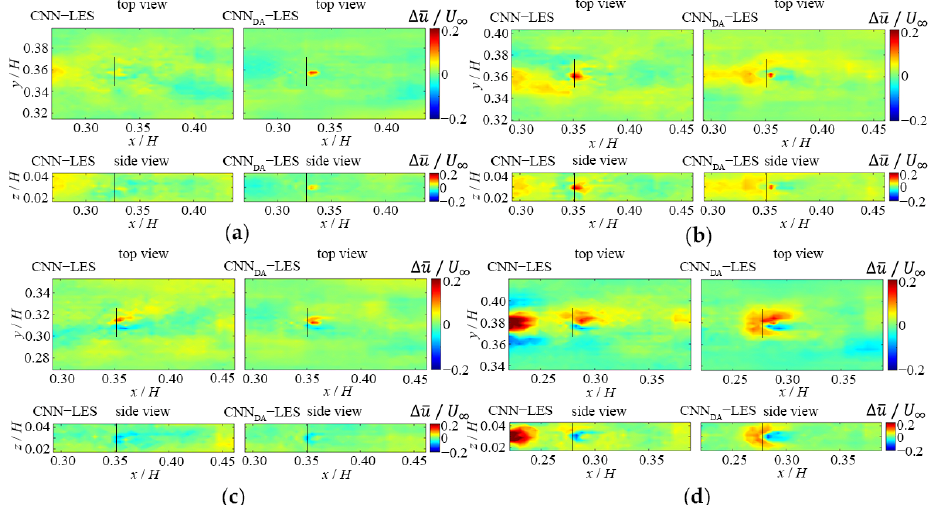
Figure 15. Contours of velocity difference between the CNN and LES results normalized with the free-flow velocity for wind turbines. ( a ) wind turbine 2 in the north-east case; ( b ) wind turbine 3 in the south case; ( c ) wind turbine 3 in the south-west case; ( d ) wind turbine 1 in the west case. Top view cross-sections are at hub-height, and side-view cross-sections are at the rotor center.